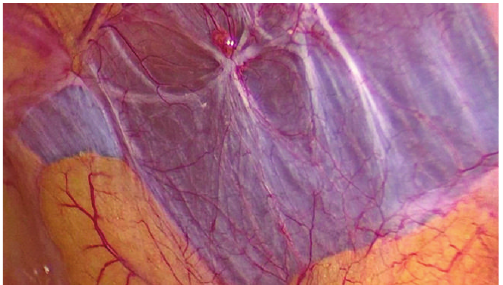
Figure 1: Right lateral pelvic wall adhesions, obstructing the proper identification of the uterus. Anatomic relations are of the upmost importance to proceed to adhesion removal.